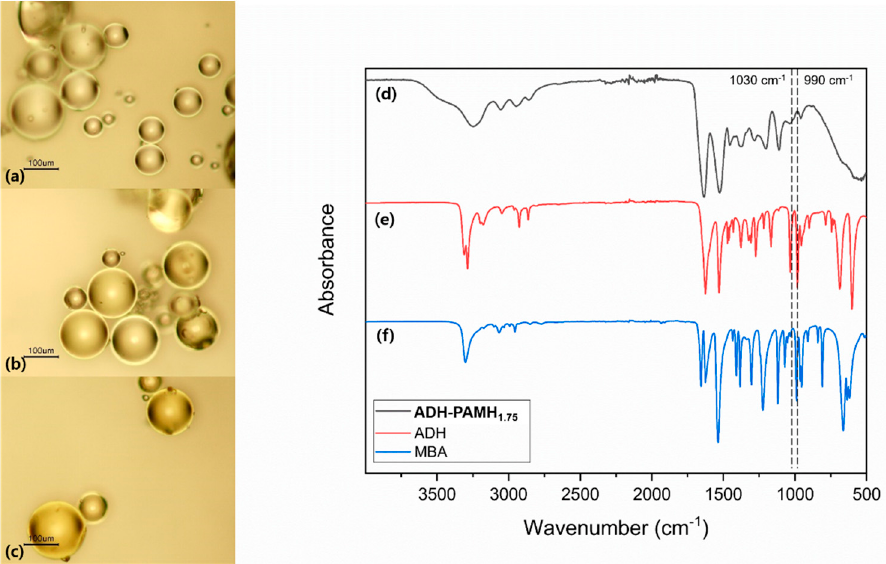
Figure 1. Optical Microscopy (OM) ( a – c ) and Attenuated Total Reflection Infrared Spectroscopy (ATR-IR) of ADH-PAMH 1.75 ( d ), ADH ( e ), MBA ( f ).